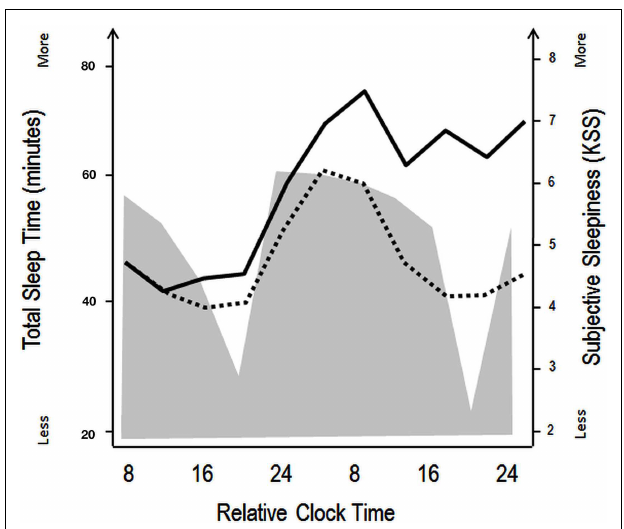
FIGURE 1 | Schematic illustration of the impact of circadian and homeostatic processes on sleep and wakefulness. The filled gray area illustrates variations in total sleep time during a constant routine protocol with regularly occurring naps (150min of wakefulness followed by 75min of naps), aiming at investigating circadian rhythm parameters under low homeostatic sleep pressure conditions. Black lines indicate superimposed subjective sleepiness as assessed by the Karolinska Sleepiness Scale over a similar nap (dashed line) and total sleep deprivation (straight line) protocol. The wake maintenance zone can be identified in the naps scheduled in the subjective evening hours, with minimal total sleep time (expressed in minutes).The sleep-promoting signal in the biological night is accompanied by rapid increases in subjective sleepiness in both the low (naps) and high (sleep deprivation) sleep pressure conditions. Over the course of the second biological day, subjective sleepiness decreases, even when homeostatic sleep pressure increases (in the sleep deprivation protocol, straight line), indicating that circadian wake promotion rises or that circadian sleep promotion diminishes [modified from Cajochen et al. (2001) and Münch et al.